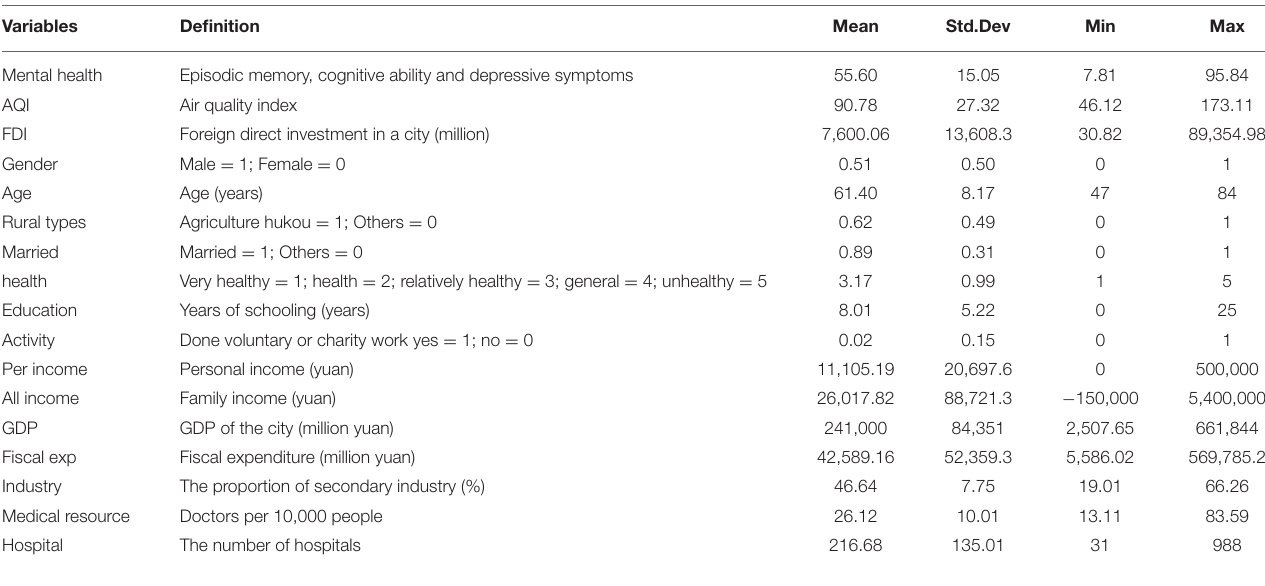
TABLE 2 | Descriptive